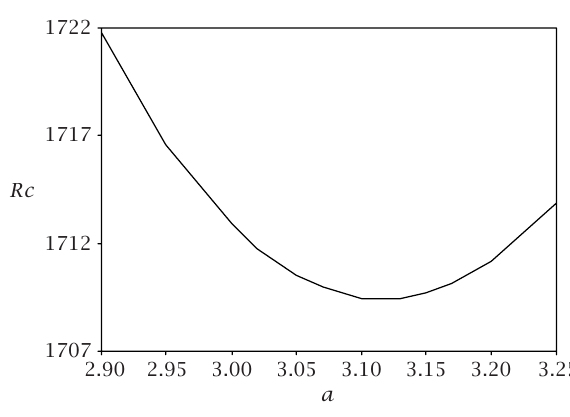
Figure 4.5 . Variation of Rc with a : P = 0 . 1, ω = 50 . 0, and ε = 0 .